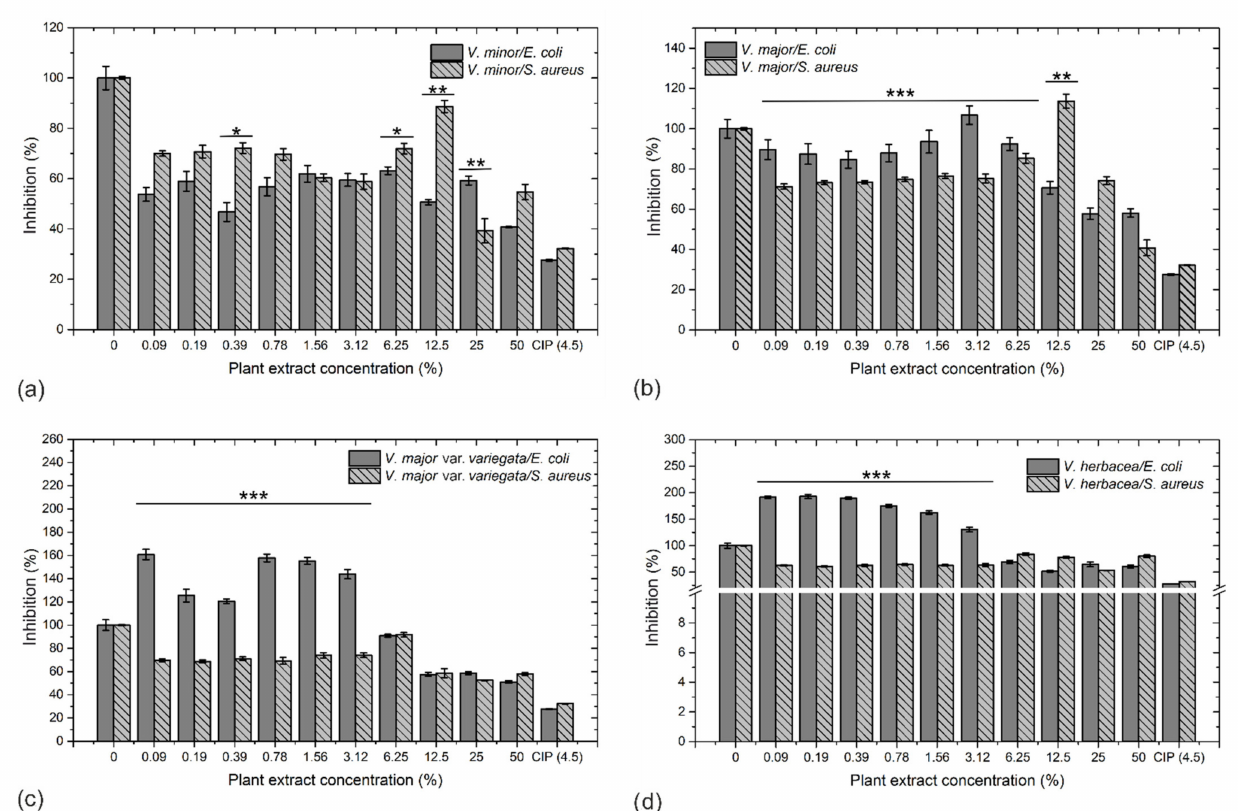
Figure 4. The antibacterial effect of Vinca minor ( a ), V. major ( b ), V. major var. variegata ( c ), and V. herbacea ( d ) leaf extracts against E. coli and S. aureus , assessed through the microdilutions method. The values represent the mean of at least three independent experiments ± standard error of the mean (s.e.m.); *** p < 0.0001, ** p < 0.001, * p < 0.05 according to one way ANOVA and Student’s t